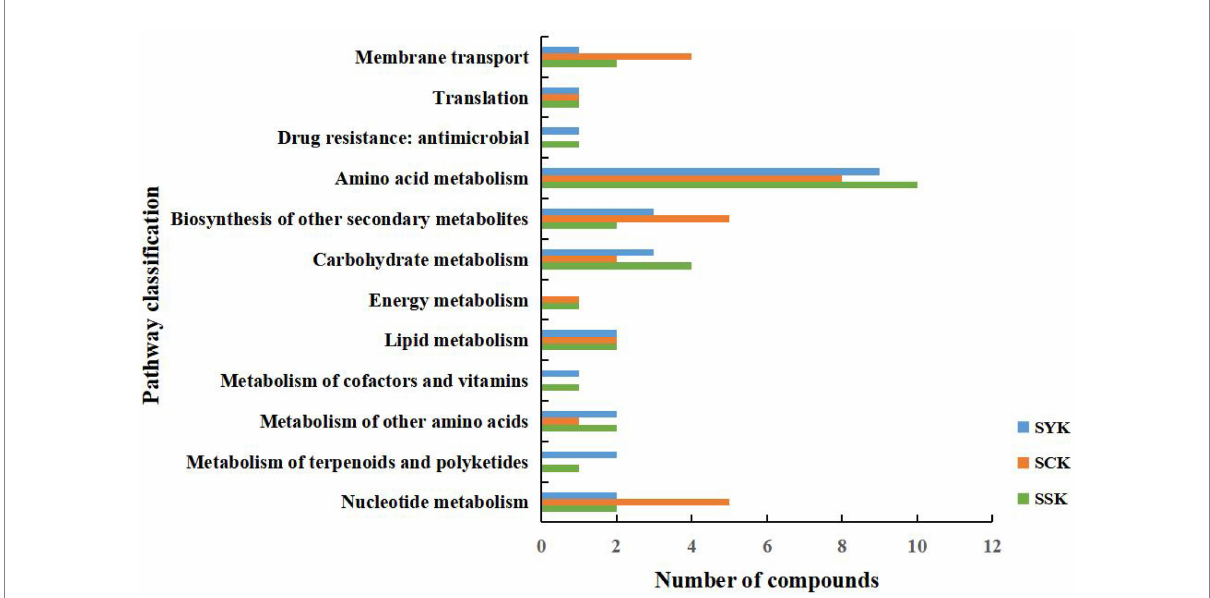
FIGURE 5 Comparison of KEGG functional pathways of main differential metabolites of ryegrass silage at different growth stages in positive and negative ion modes. SYK, Silage samples at booting stage; SCK, Silage samples at initial flowering; SSK, Silage samples at full